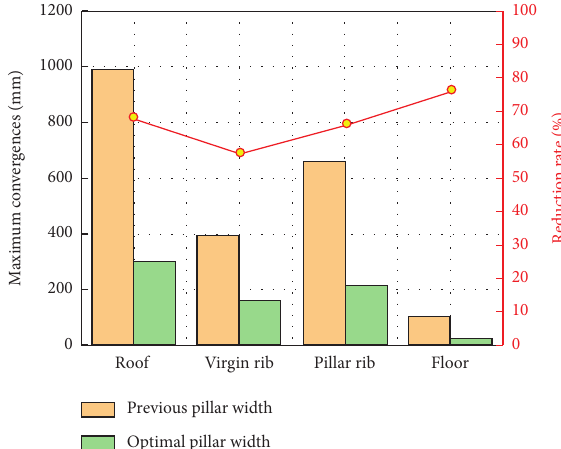
Figure 22: Comparison of roadway convergences during panel 8103 retreat.